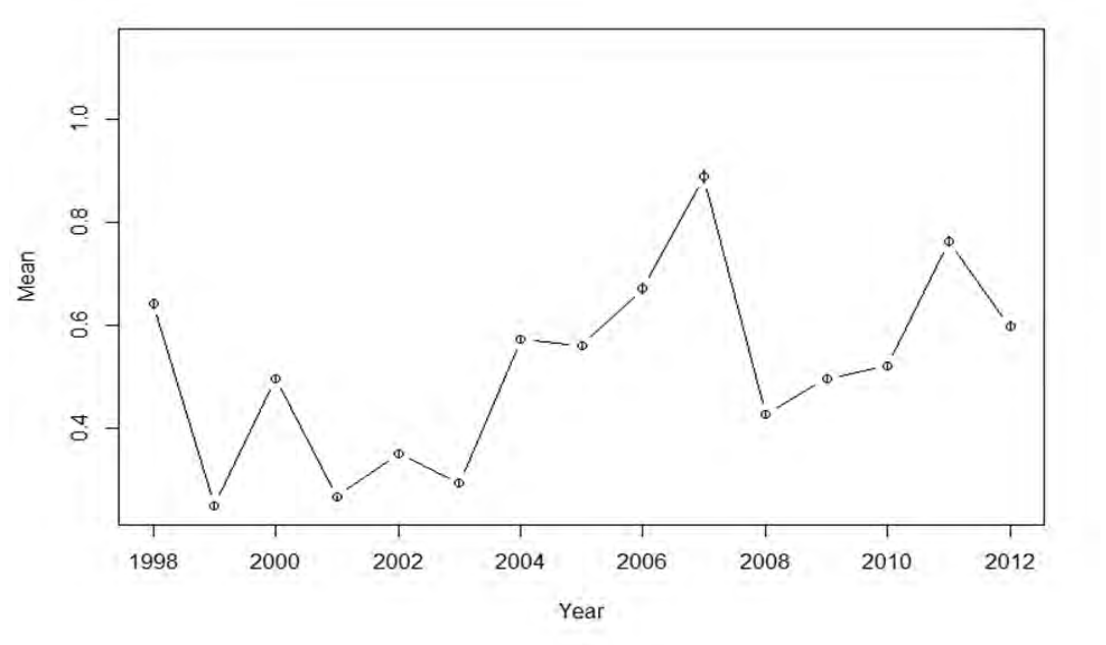
Figure 50. Abundance index for adult female horseshoe crabs (> 180 mm pw) in New Jersey’s Surf Clam Dredge Survey (June, July,